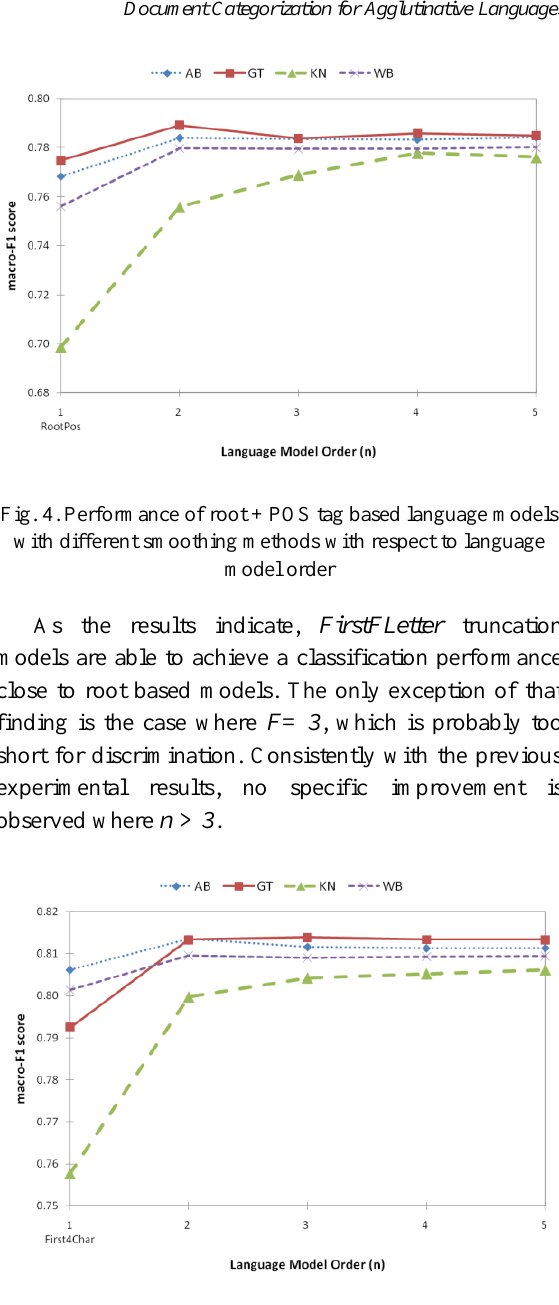
Fig. 5. Performance of the First4Letter based language models with smoothing methods with respect to language model